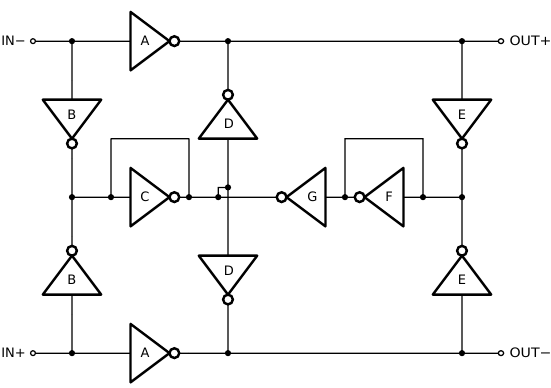
Figure 10. Barthelemy/Manfredini (B/M) hybrid OTA circuit diagram.